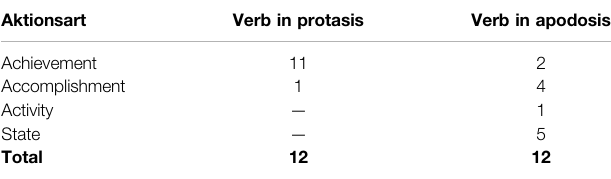
TABLE 2 | Aktionsart distribution of the German